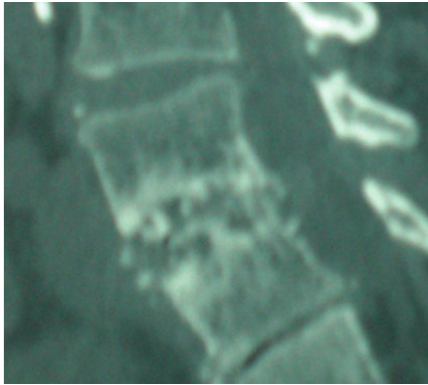
Figure 7: Sagittal CT scan image showing bony destruction of L4 and L5 (Case